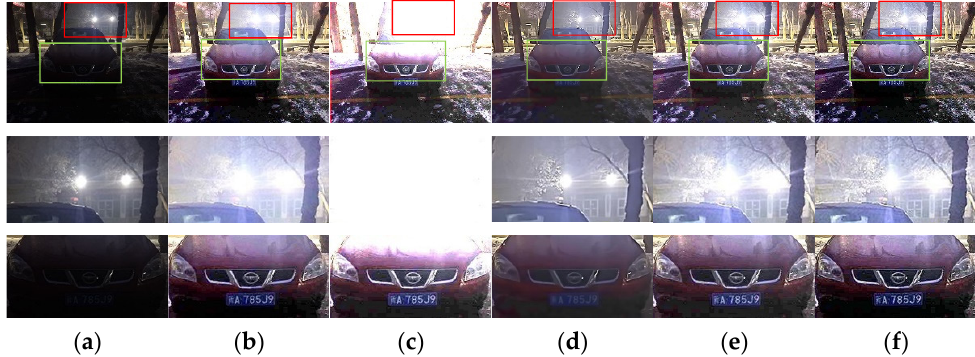
Figure 10. ( a ) Test image and its detail maps. The remaining images are the enhancement results and their detail maps, generated by the following methods: ( b ) ALSM, ( c ) Li et al. [26], ( d ) LR3M, ( e ) LIME, and ( f ) the proposed method.